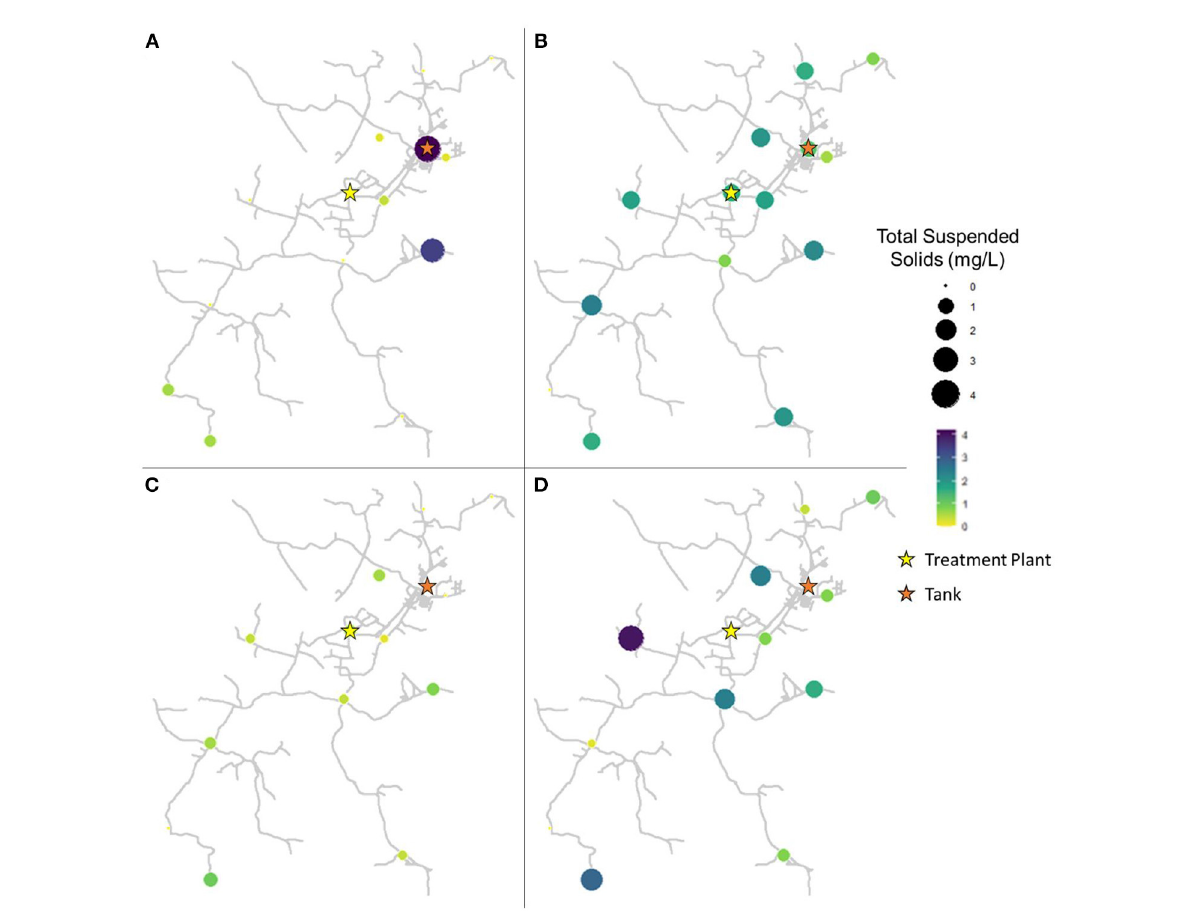
FIGURE2 Total suspended solids in samples collected at all sites in (A) March (2 weeks before flushing), (B) April (1 week after flushing), (C) June (9 weeks after flushing), and (D) August (16 weeks after flushing).